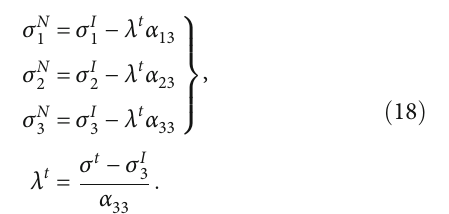
algorithm. Given the stress state at time t and the total strain